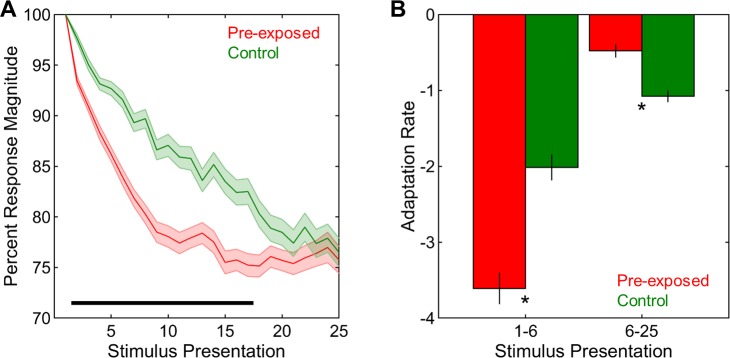
Adaptation in pre-exposed and control conditions.(A) Percent response magnitudes across stimulus presentations were smaller in the pre-exposed than in the control condition. (B) Adaptation rates in the pre-exposed condition were more negative for presentations 1–6 and less negative for presentations 6–25 than those in the control condition. Shadings and error bars indicate SEMs. Horizontal black bar and asterisks denote significant differences.